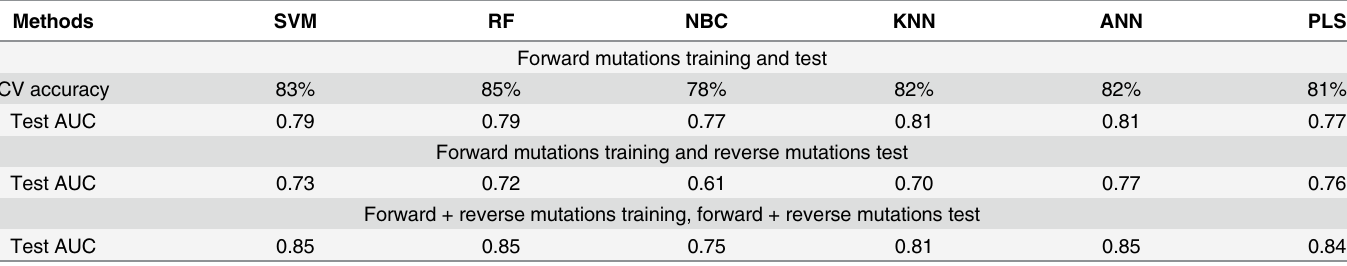
Table 13. dTm binary classification with forward and reverse